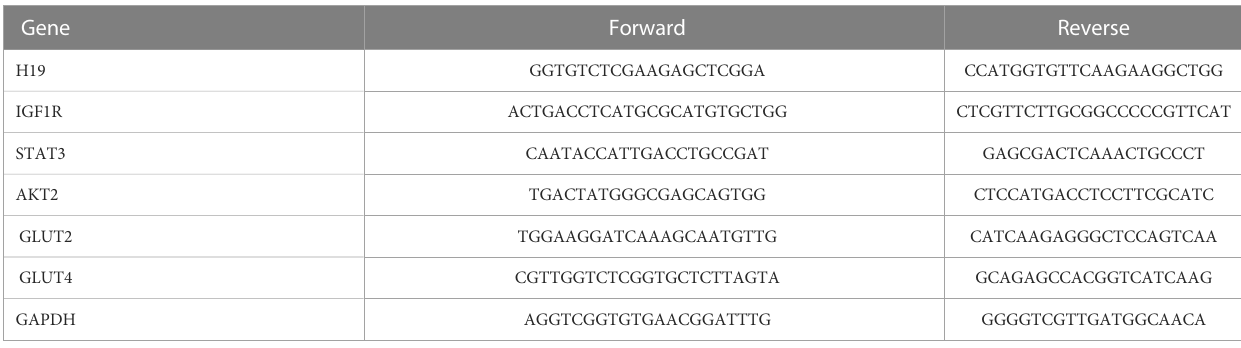
IGF1R, insulin-like growth factor 1 receptor; AKT2, AKT serine/threonine kinase 2; STAT3, signal transducer and activator of transcription 3; GLUT2, glucose transporter 2; GLUT4, glucose transporter 4; GAPDH, glyceraldehyde phosphate dehydrogenase.